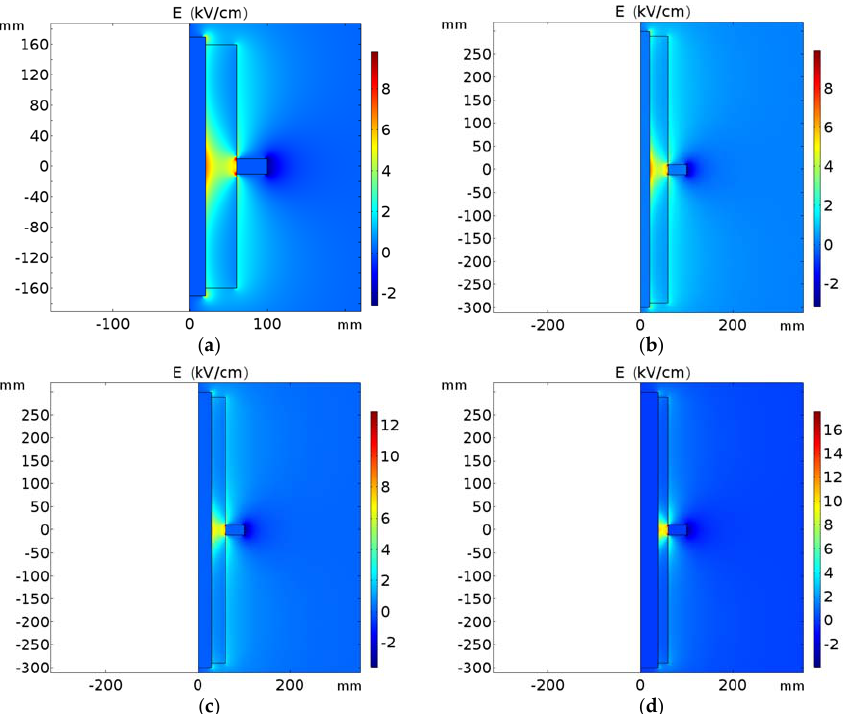
Figure 7. Simulated vertical electric field component vertical to the dielectric surface of all the four bushing samples. ( a ): sample A; ( b ): sample B; ( c ): sample C; ( d ): sample D. Table 3. Calculated maximum electric field component vertical to the dielectric surface of all four bushing samples.